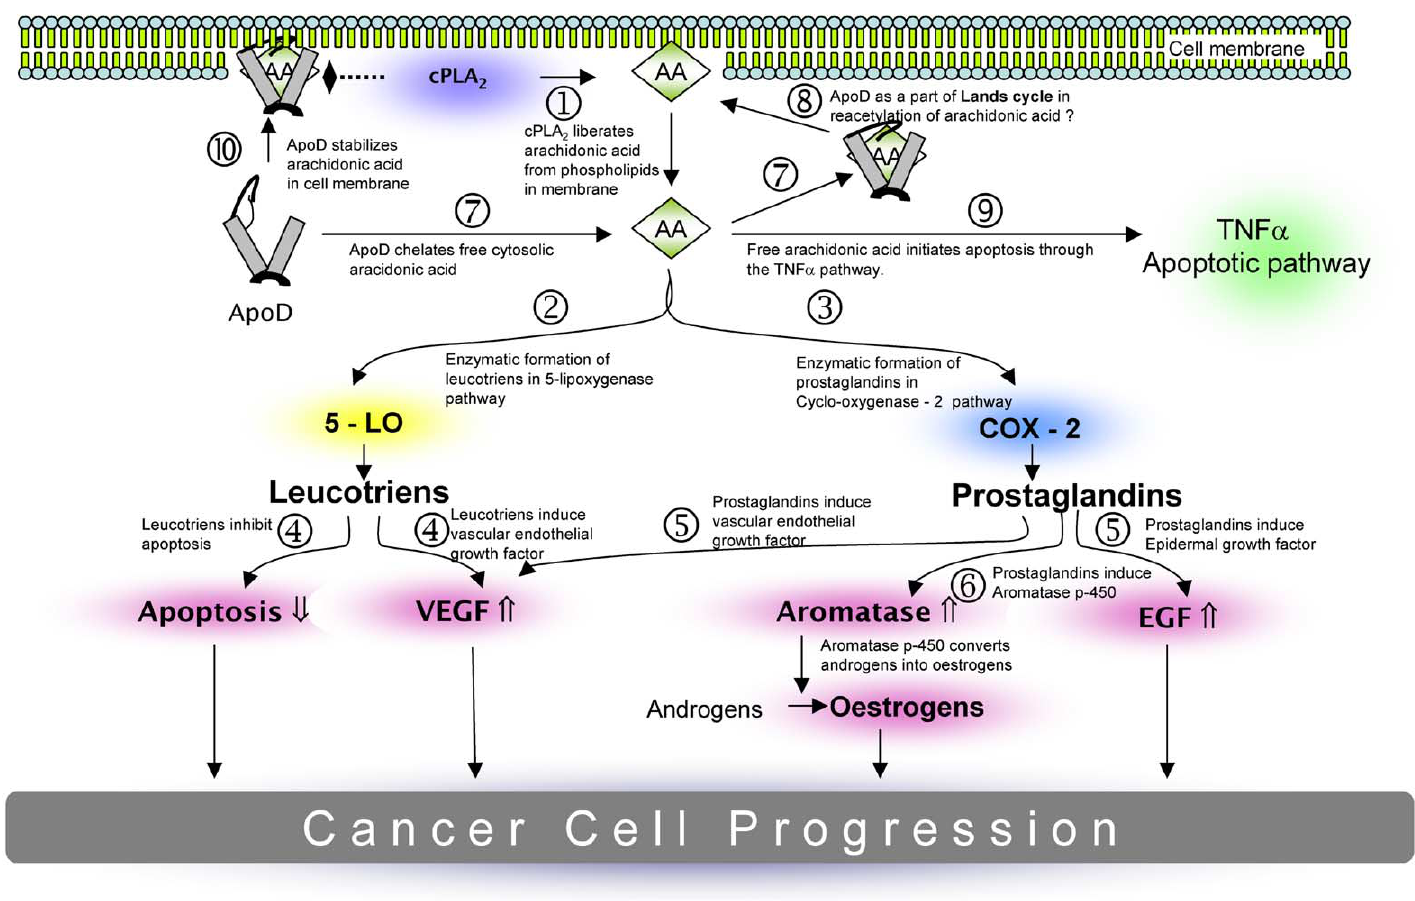
Fig. 5. Importance of ApoD in arachidonic acid (AA) signaling pathways. Adapted from references [73,99] and [100]. The main message in the figure is that ApoD could be a factor that has a strong influence on the availability of free arachidonic acid in the cell. The numbers indicate the sequence of different reactions/interactions. Abbreviations: 5-LO: 5-lipoxygenase; AA: arachidonic acid; cPLA 2 : cytoplasmic phospholipase A 2 ; COX-2: cyclo-oxygenase 2; ER: oestrogen receptor; EGF: epidermal growth factor; TNF α : tumour necrosis factor alfa; VEGF: vascular endothelial growth factor. 1. cPLA 2 cleaves the binding between glycerol and AA and liberates AA into the cytoplasm. 2. AA is the 5-LO enzyme substrate. 3. AA is the COX-2 enzyme substrate. 4. Leucotriens increase VEGF pathway in neoangiogenesis and inhibit apoptosis. 5. Prostaglandins crosstalk with the EGF pathway and neoangiogenesis via the VEGF pathway. 6. Prostaglandins stimulate transcription of aromatase and crosstalk with the ER pathway. 7. Apo D binds/chelates free AA in the cytosol and removes it from the free functional substrate pool of the enzymatic pathways described in 2 and 3. 8. ApoD may be part of the Lands’ cycle, where free AA is esterified back in the phospholipids bilayer membrane in order to keep a low level of free arachidonic acid in the cytoplasm. 9. Increased free arachidonic acid is toxic for the cell and initiates apoptosis through the TNF- α pathway. 10. ApoD protects liberating of AA in the plasma membrane against the enzymatic cleavage function of cPLA 2